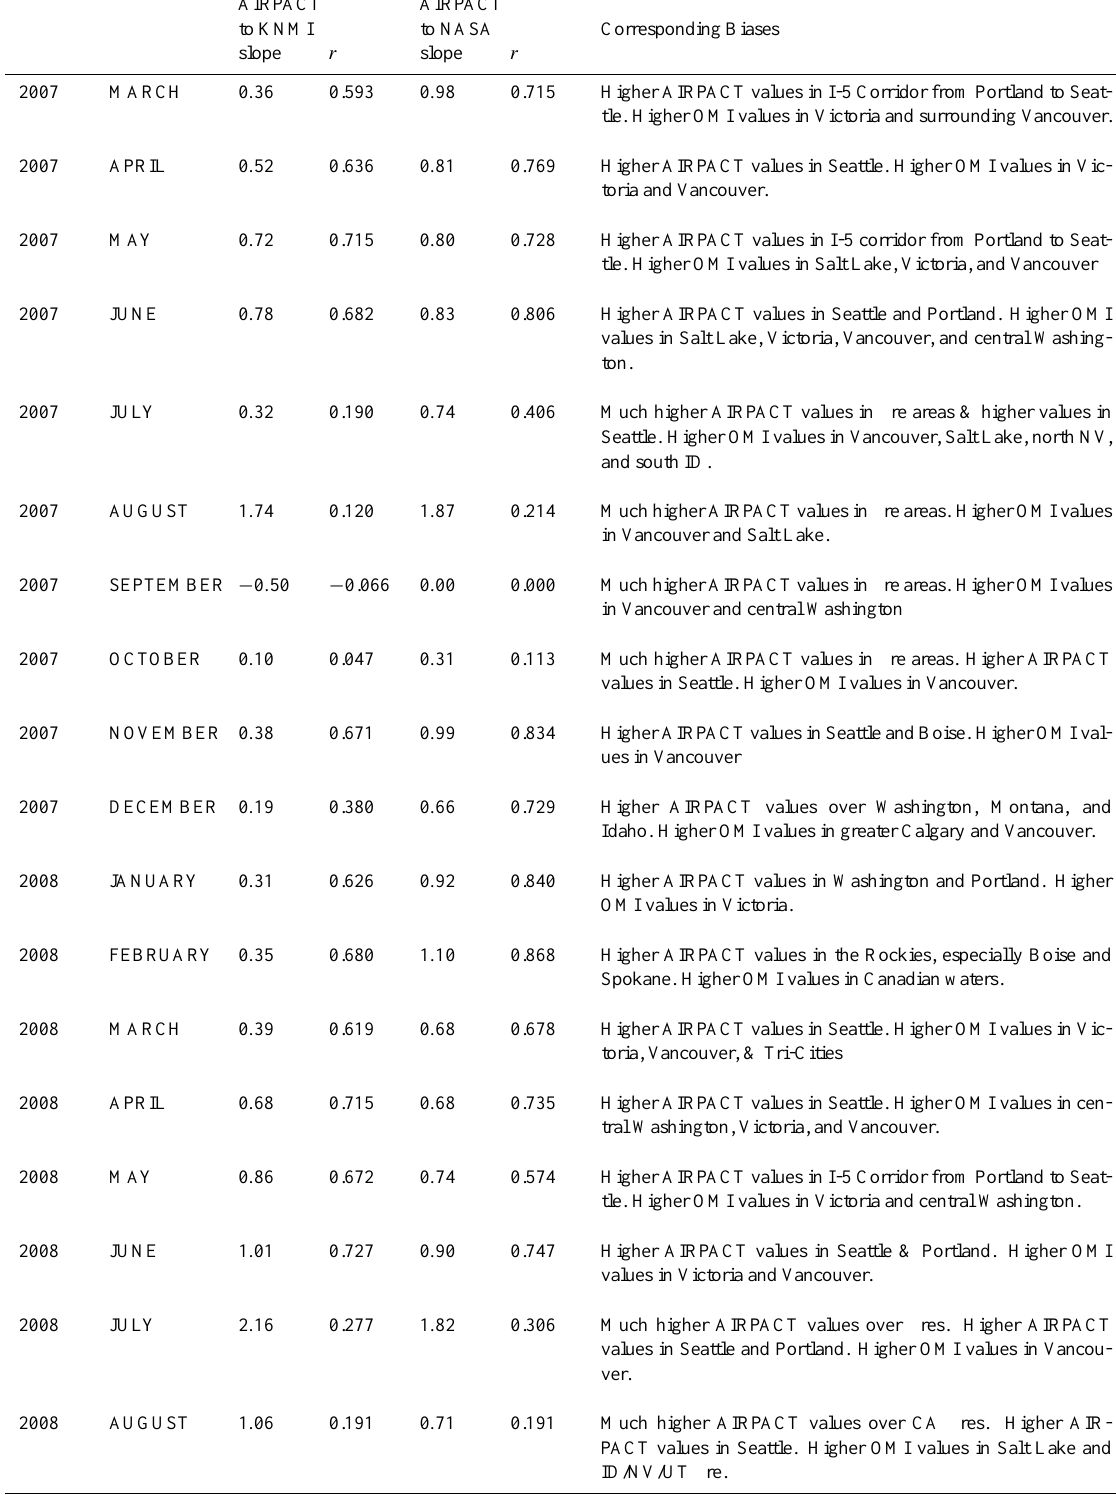
Table 2. Linear correlation and best fit slope of AIRPACT-3 to OMI tropospheric NO 2 column monthly averages for the entire domain. Corresponding areas where both KNMI and NASA showed the same relative bias to AIRPACT are